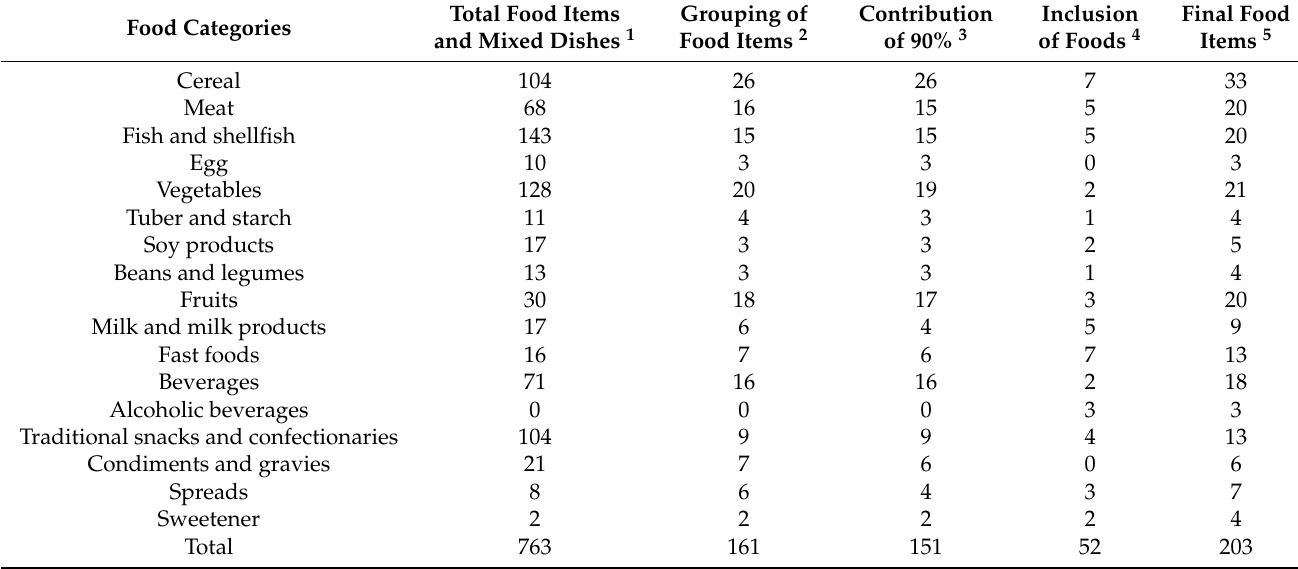
Table 3. Food categories of the semiquantitative food frequency questionnaire derived from 803 participants. Food Categories